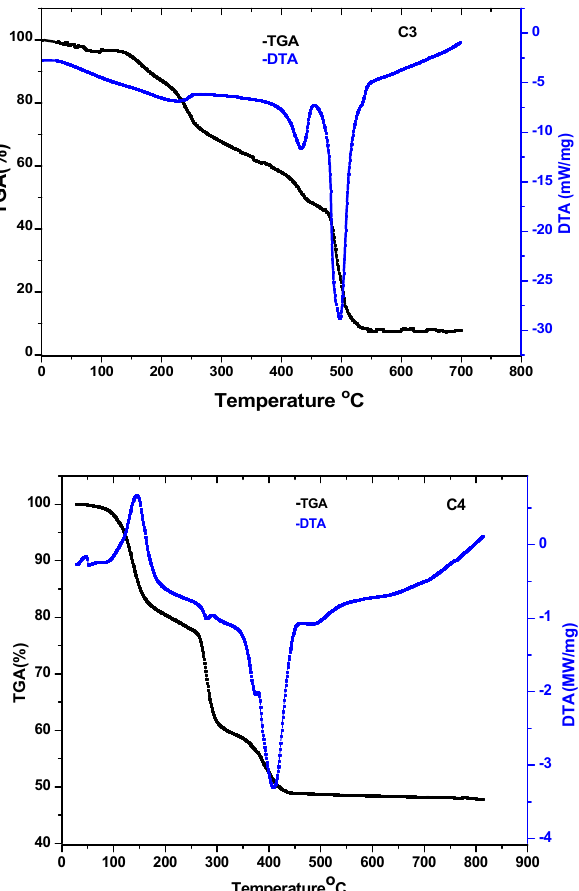
Figure 2. TGA and DTA of C3 (top) and C4 (bottom). The thermograms of C2 and C4 showed a similar pattern of degradation. The four deflections in the thermogram indicate the thermal instability of the complexes. During the early stages of the degradation process, lattice water and chloride get eliminated over a temperature range of 78–230 ◦ C with a loss of 8.91% (calcd. 8.91%). A major weight loss of 30.43% (calc. 30.23%) was attributed to the elimination of 1,10-phenantholine around 265–330 ◦ C. The third deflection in the thermogram, due to the degradation of 5-fluorosalicyladihyde, appeared at 390–470 ◦ C, with a mass loss of 19.35% (20.16%). Finally, aminomethylbenzimidazole left, with a weight loss of 24.35% (calcd. 24.69%) over the range 490–520 ◦ C. Above 540 ◦ C, a constant thermal stability indicates the formation of respective metal